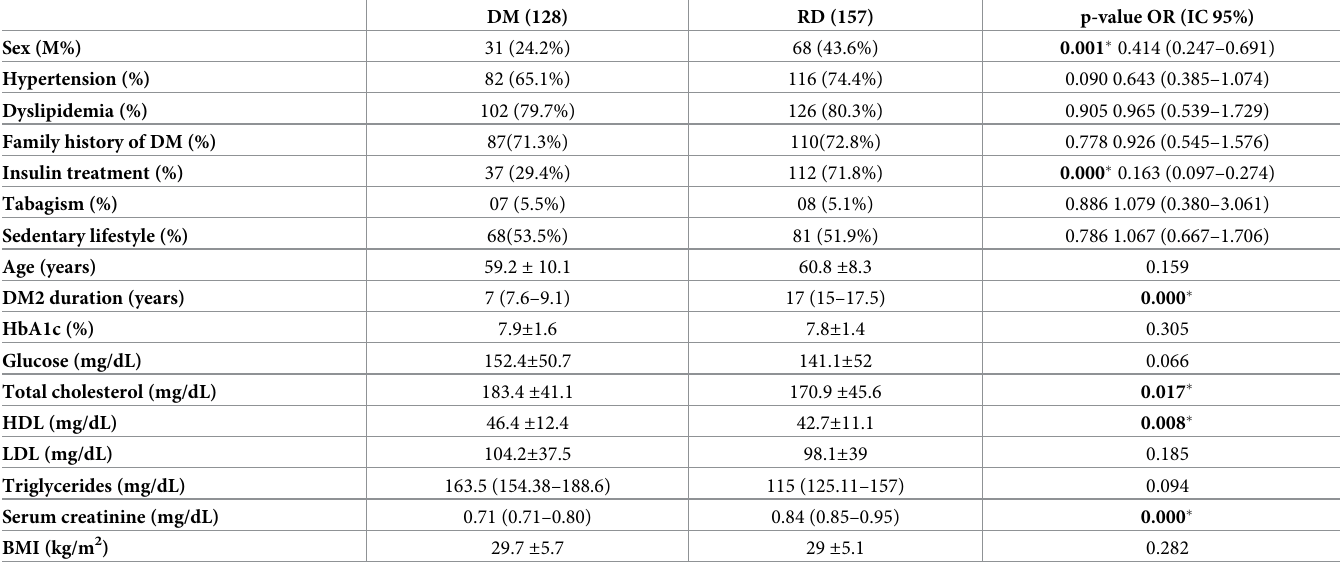
Table 1. Clinical, biochemical and metabolic parameters of the studied